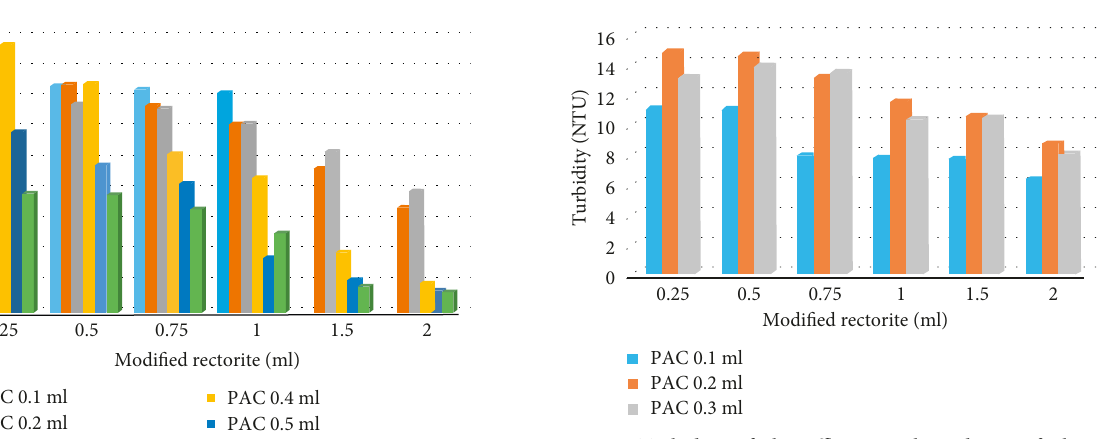
Figure 9: Turbidity of the effluent with 2 drops of chitosan, polyaluminum aluminum chloride, and modified rectorite.